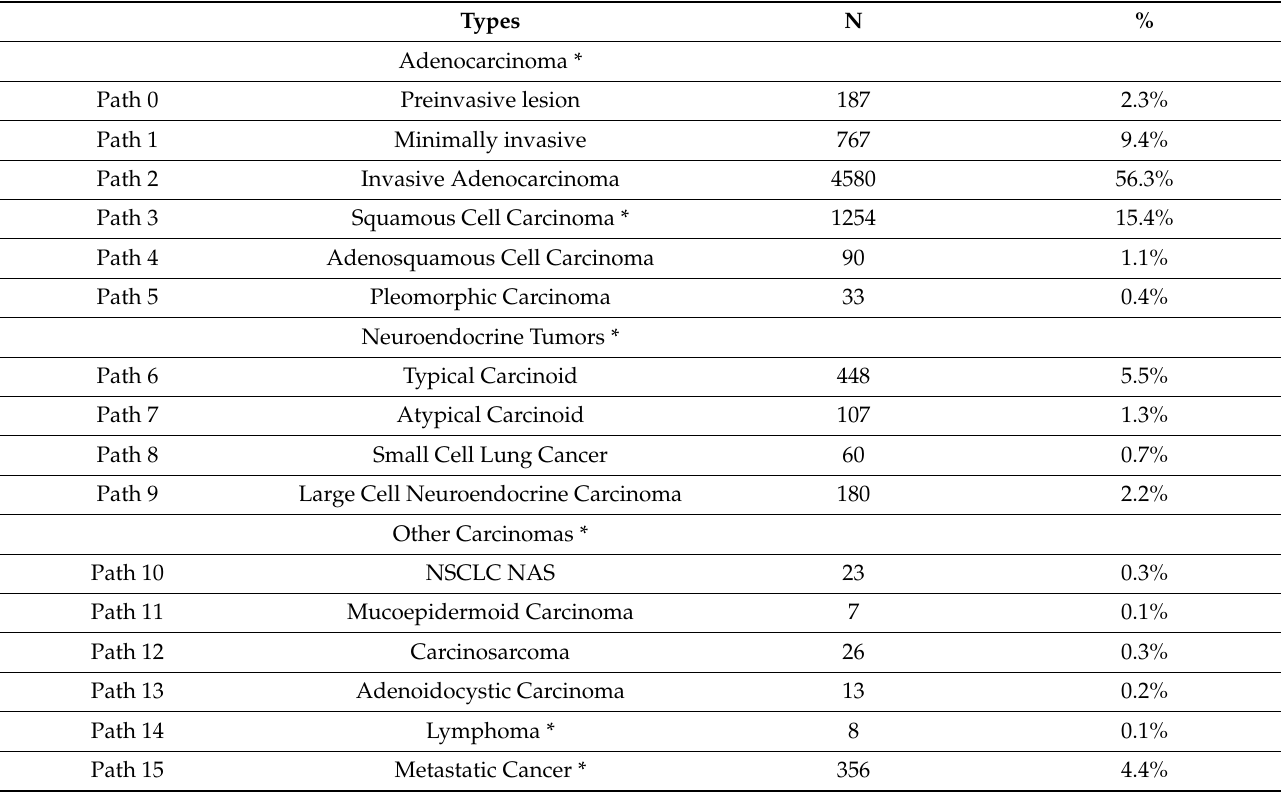
Table 2. Histological types according to the “2015 WHO Classification of Lung Tumors” [12].